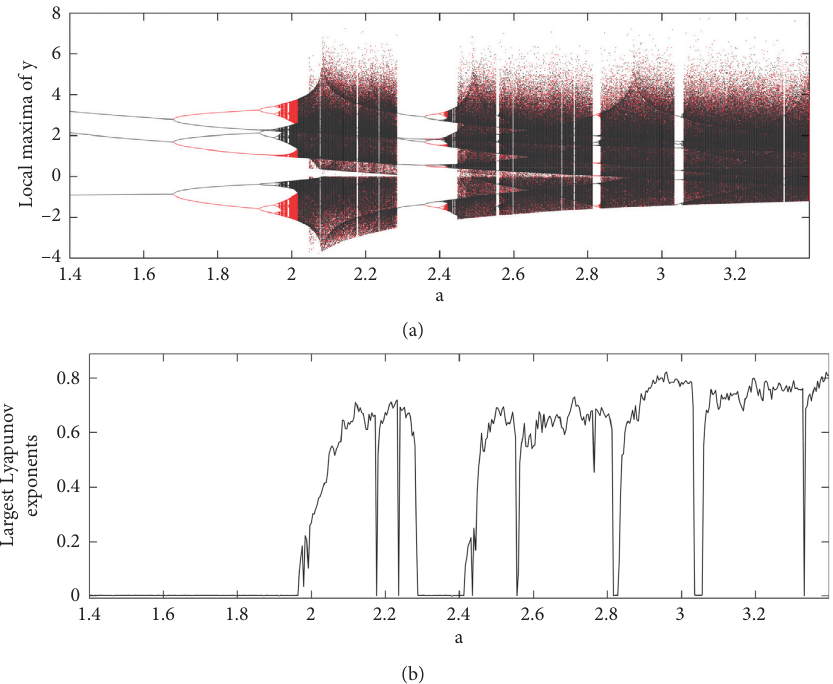
Figure 2: Bifurcation diagrams of y ( t ) (a) and LLE (b) of SynRM versus the parameter a for b � 0 . 2 and c � 22. Bifurcation diagrams are obtained by scanning the parameter a upwards (black) and downwards (red). The initial conditions are ( x ( 0 ) , y ( 0 ) ,z ( 0 )) � ( 0 . 1 , 0 . 2 , 0 . 2 )